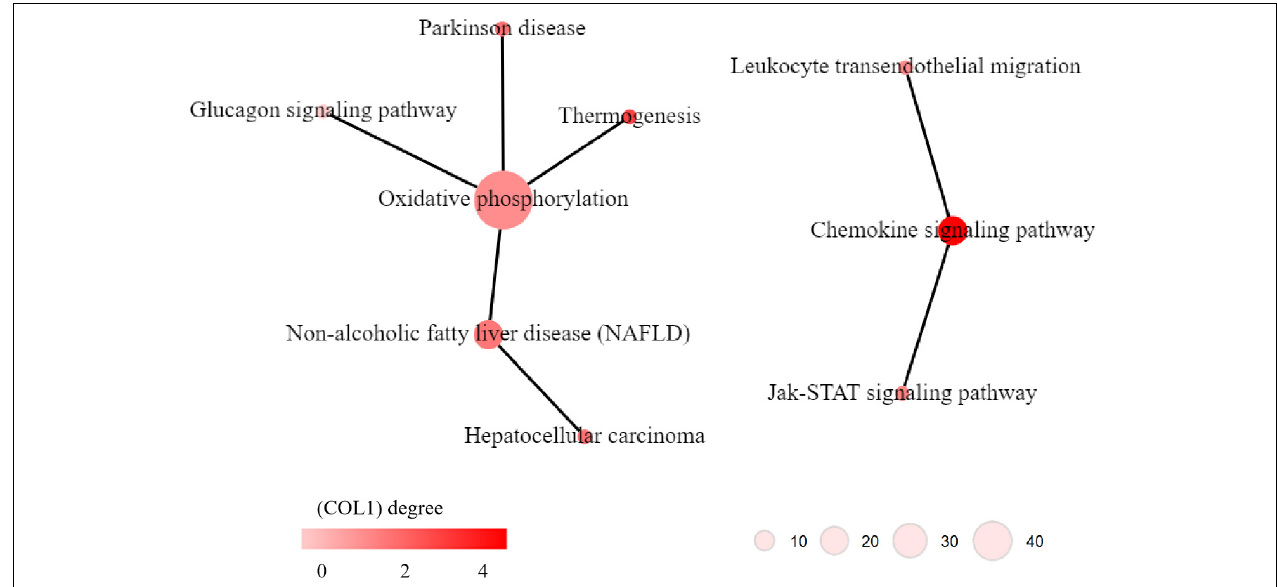
FIGURE 6 | Kyoto Encyclopedia of Genes and Genomes (KEGG) pathway networks of dysregulated pathways in major depressive disorder (MDD). The circles indicate KEGG pathways. The edge between two pathways indicates that there is a relationship between the two pathways. The color of the circles indicates the degree of the pathways, i.e., how many edges linking to this